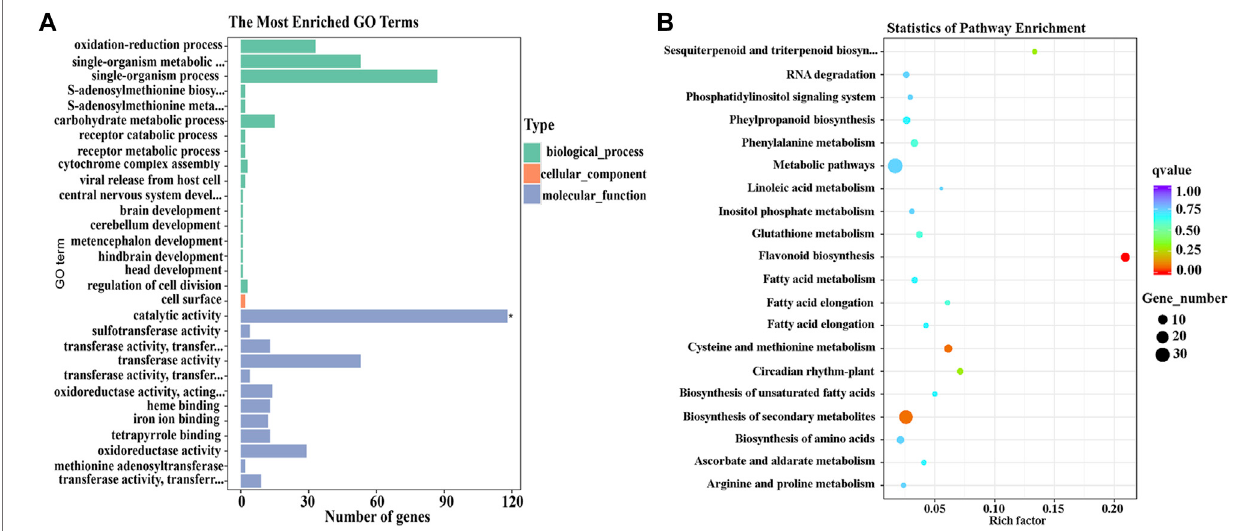
FIGURE 3 | GO and KEGG pathways enriched for 424 differentially expressed genes (DEGs) that potentially in fl uence eggplant fruit apex color. (A) Analysis of GO terms enriched for the 424 DEGs. (B) The top 20 KEGG pathways enriched for the 424 DEGs.